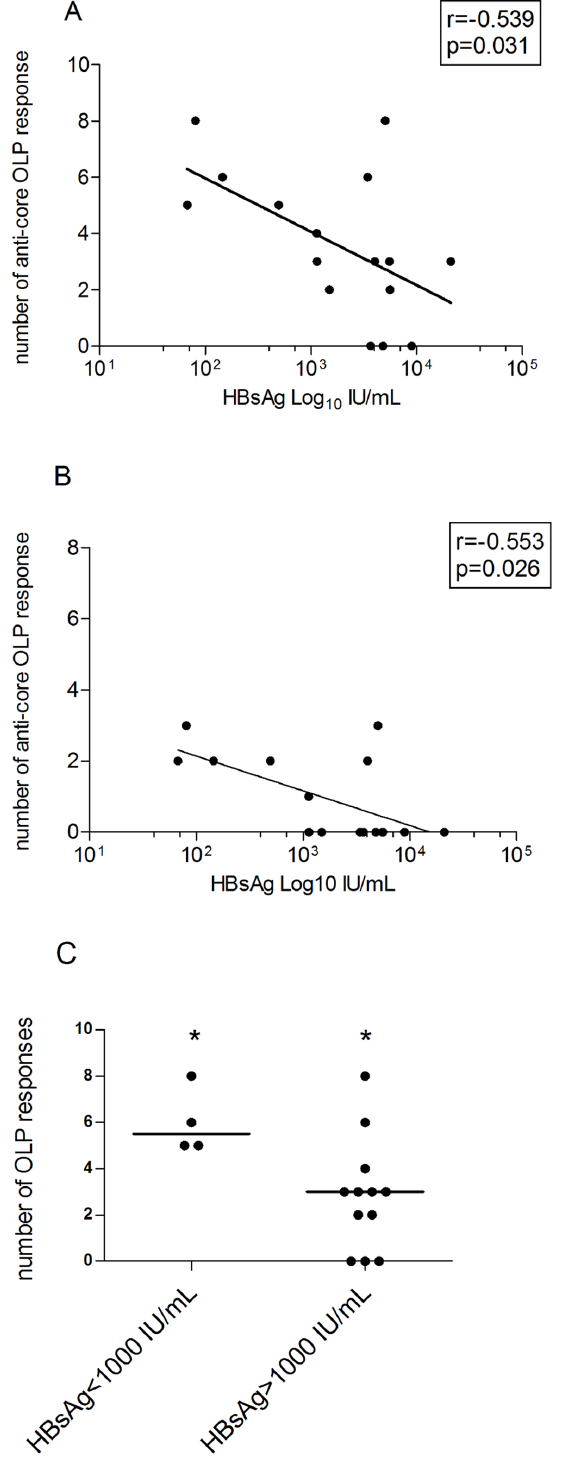
Figure 4. HBV specific T cell response and HBV serovirological markers in treated patients. A) Correlation between the breadth of the HBV specific T cell response (number of targeted peptides) and HBsAg serum levels (IU/mL) in the 16 treatment-suppressed patients. B) Correlation between breadth of the HBV specific T cell response and HBV-DNA serum levels (IU/mL). For A) and B), Regression line, r coefficient and p value (Spearman Ranks test) are shown. HBV-DNA axis in logarithmic scale. C) Number of responses in the 16 treated